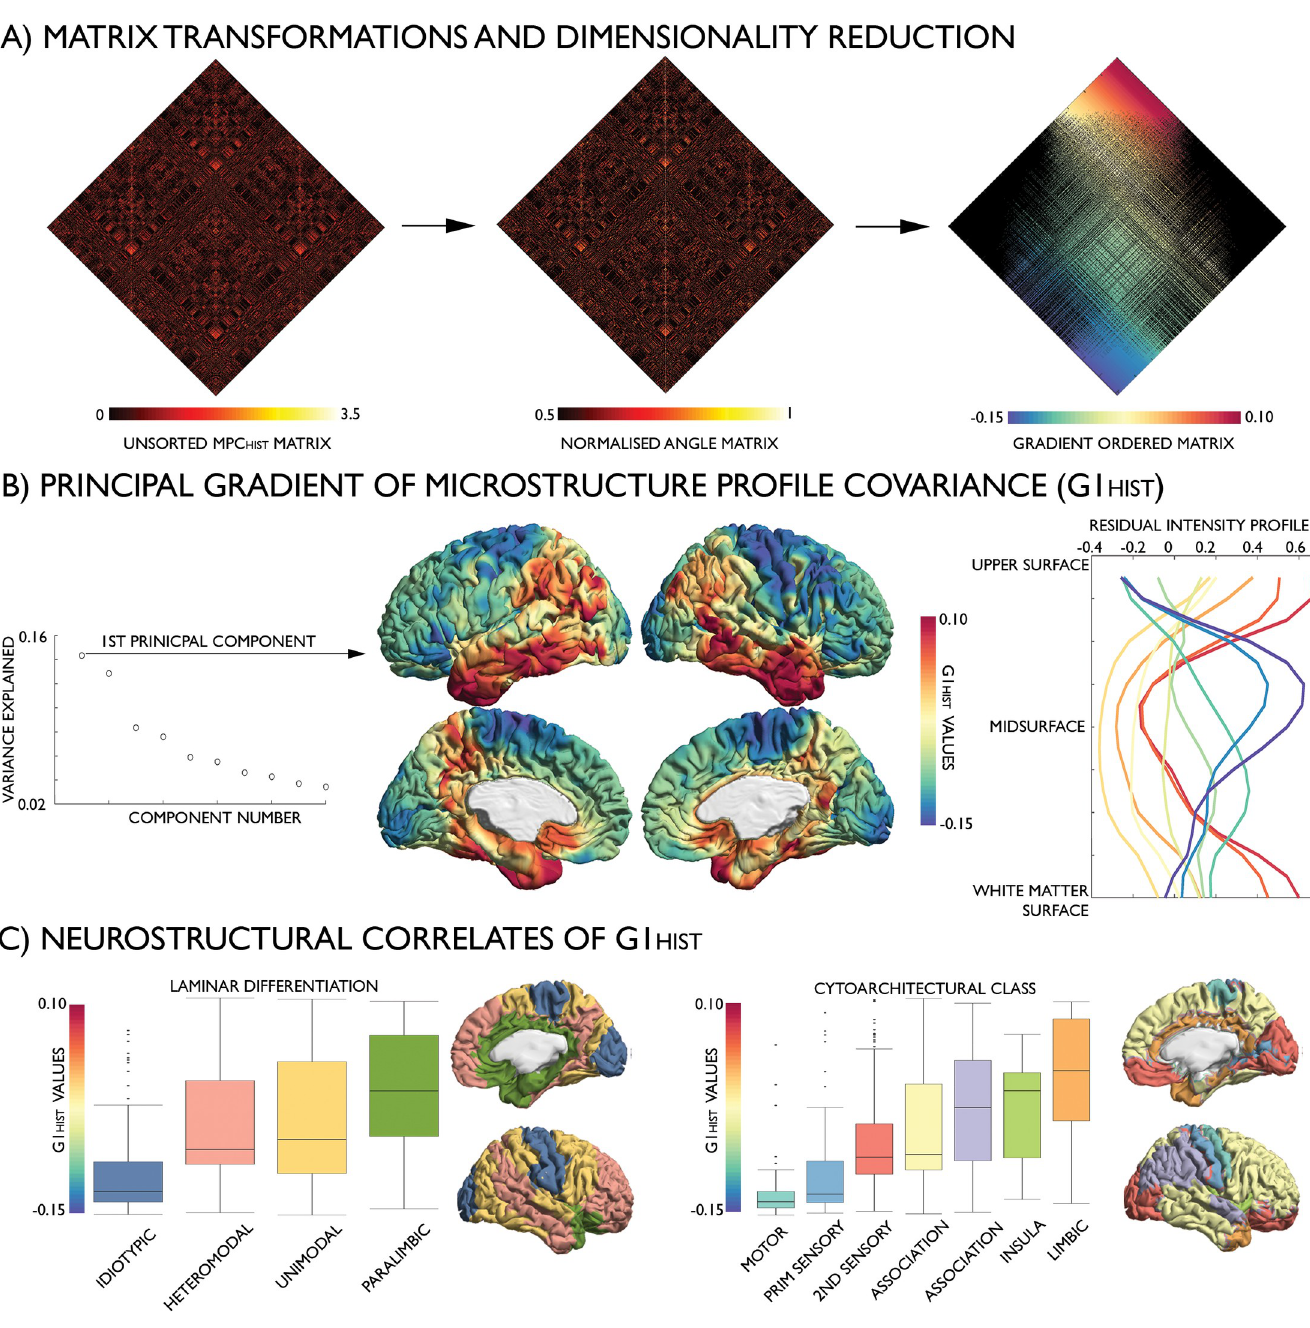
Fig 2. The G1 HIST of the histology-based MPC HIST . (A) Identification: the MPC HIST matrix was transformed into an affinity matrix, which captures similarities in MPC HIST between nodes; this affinity matrix was subjected to diffusion map embedding, a nonlinear compression algorithm that sorts nodes based on MPC HIST similarity. (B) Variance explained by embedding components (left). The first component, G1 HIST , describes a gradual transition from primary sensory and motor (blue) to transmodal and limbic areas (red), corresponding to changes in intensity profiles, illustrated with the mean residual intensity profile across 10 discrete bins of the gradient (right). (C) Spatial associations between G1 HIST and levels of laminar differentiation (left; [40]) and cytoarchitectural taxonomy (right; [13,41]), ordered by median. Histological data is openly available as part of the BigBrain repository (https://bigbrain.loris.ca/main.php). G1, first principal gradient; HIST, histology-based; MPC, microstructure profile covariance.